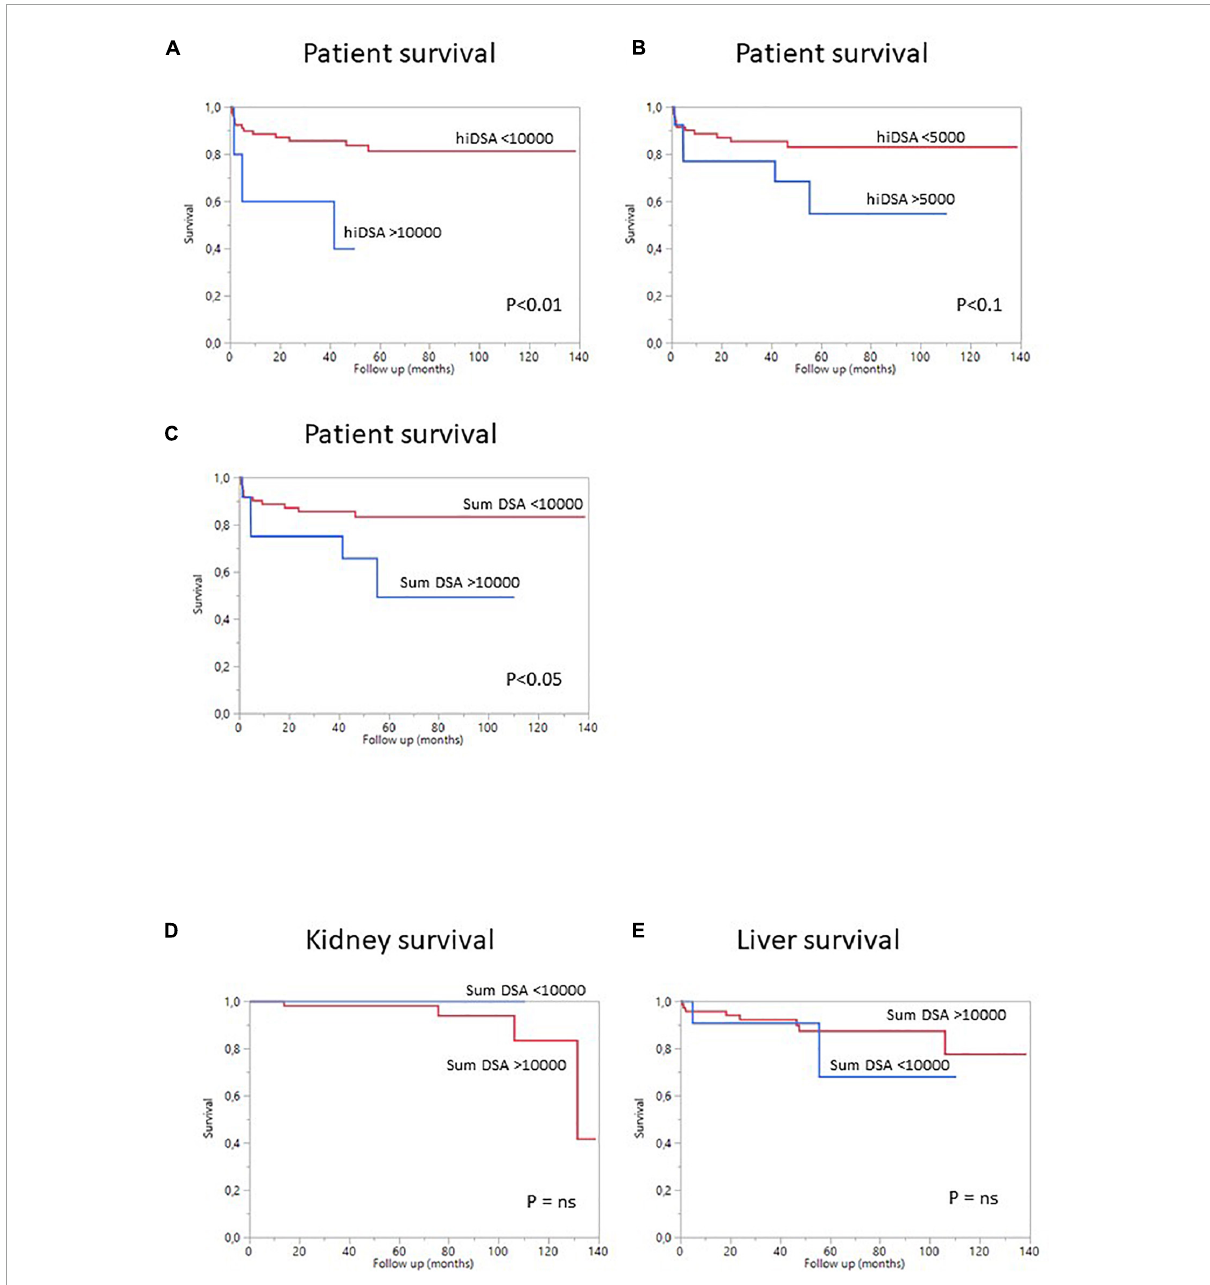
FIGURE2 Survival curves for SLKT patients according to pDSA status. (A) Survival curves for patients with a highest pDSA with a MFI > 10,000 (blue) or a highest pDSA with a MFI < 10,000 MFI (red). (B) Survival curves for patients with a highest pDSA with a MFI > 5,000 MFI (blue) or a highest pDSA with a MFI < 5,000 (red). (C) Survival curves for patients with a MFI for total pDSA > 10,000 MFI (blue) or a MFI for total pDSA < 10,000 MFI (red). (D) Death-censored kidney survival in patients with a highest pDSA with a MFI > 10,000 (blue) or < 10,000 (red). (E) Death-censored liver survival in patients with a highest pDSA with a MFI > 10,000 (blue) or < 10,000 MFI